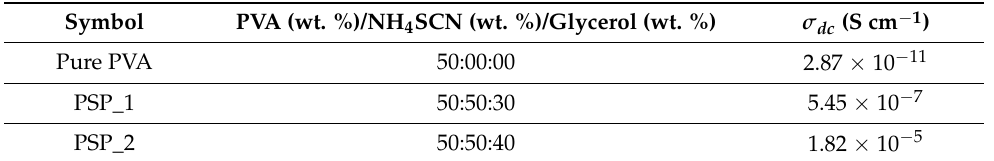
Table 3. The conductivity of the films at